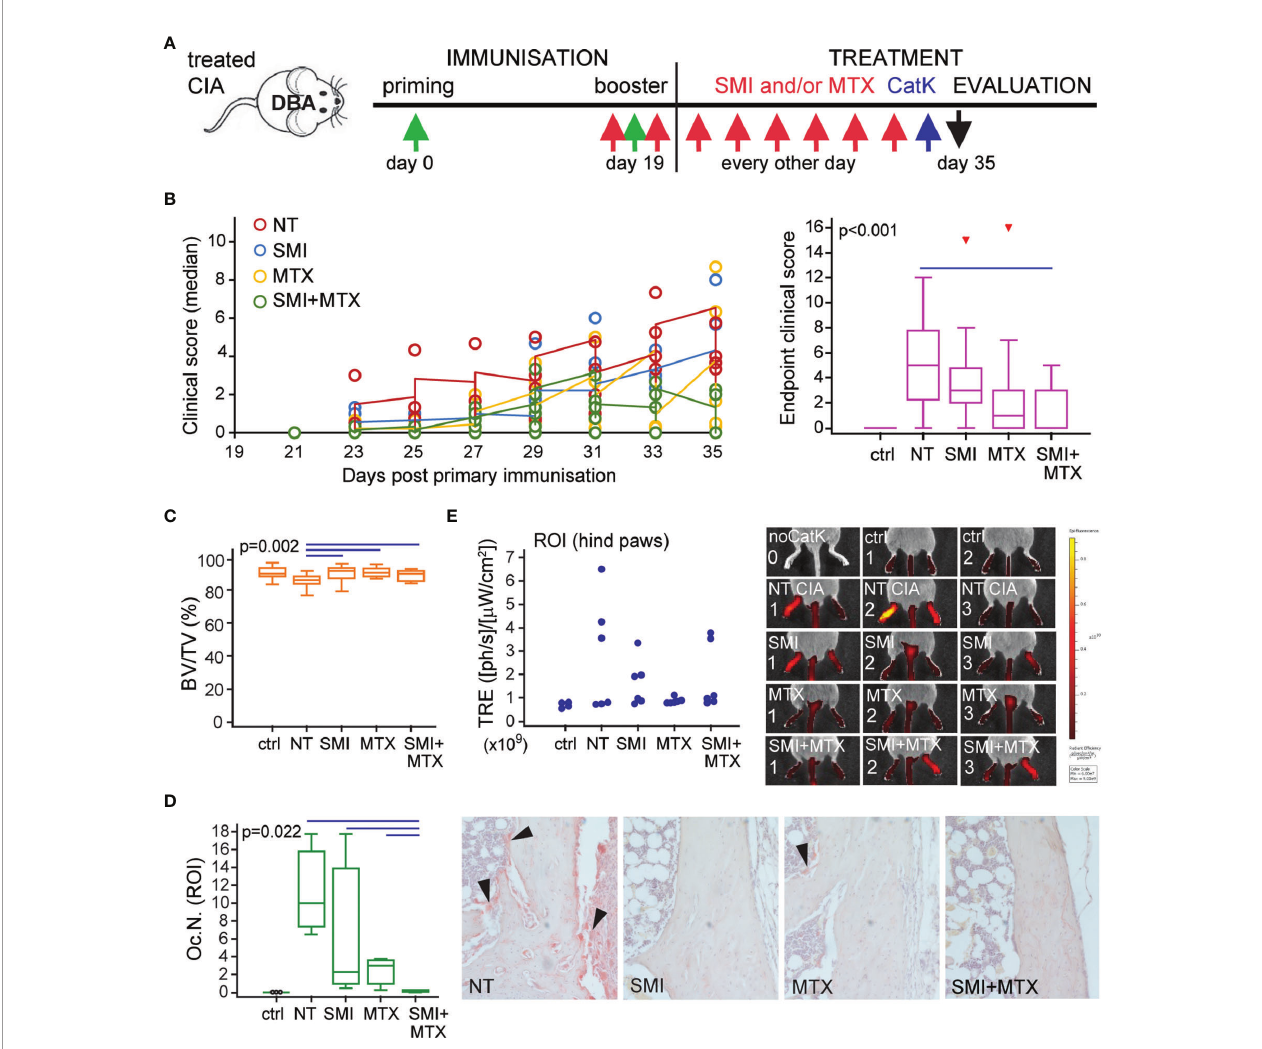
FIGURE 8 | Small-molecule inhibitor of CCR2 (SMI) alone or in combination with methotrexate (MTX) contributes to reduced clinical score and bone resorption in DBA mice with collagen-induced arthritis (CIA). (A) Experimental timeline for CIA model and preventive treatment in DBA mice. Starting approximately at day 19 (± 2 days) after the primary immunization, asymptomatic DBA mice were allocated to experimental groups [non-treated (NT) CIA, SMI CIA, MTX CIA, or combined SMI+ MTX CIA] and treated every 48 h by intraperitoneal injections. Non-arthritic group was included as control (ctrl). (B) Follow-up of the disease clinical scores (left), presented as medians per group for each experiment (total of six experiments) and statistical analysis of clinical score values at experiment endpoint (right) for ctrl, NT, and treated groups. Pooled data from six independent experiments are shown (left, each circle represents median of n = 3 – 4 mice per group per experiment). (C) Micro-computed tomography (µCT) analysis of talar bone volume [total bone volume/total tissue volume, BV/TV (%)] for ctrl, NT, and treated groups. (D) Number of tartrate-resistant acid phosphatase (TRAP) + osteoclasts (Oc.N.) present in distal tibia endosteal surfaces (region of interest, ROI) for ctrl, NT, and treated groups. Representative images of distal tibia sections histochemically stained for TRAP activity are presented (magni fi cation 100×); black arrows – areas with TRAP + osteoclasts. (E) Two-dimensional epi fl uorescence imaging of CatK 680 FAST probe activation in region of interest (ROI, intact hind paws). Data from one experiment ( n = 3 mice per group) are shown, and each dot represents the signal intensity measured in a single hind paw. Representative images of IVIS Spectrum epi fl uorescence imaging of CatK 680 FAST probe signal 24 h after intraperitoneal administration; noCatK — ctrl mouse that did not receive CatK probe. For (B) (right), (C, D) , values are presented as medians (middle horizontal lines), boxes represent the interquartile range (IQR), whiskers represent 1.5 times the IQR, and outliers are represented by triangles. Statistically signi fi cant difference was determined at p < 0.05, Kruskal – Wallis test ( p -value marked on the graph) with Conover post-hoc test for group-to-group comparisons; line denotes signi fi cant difference between groups. TRE, total radiant ef fi ciency; ph,